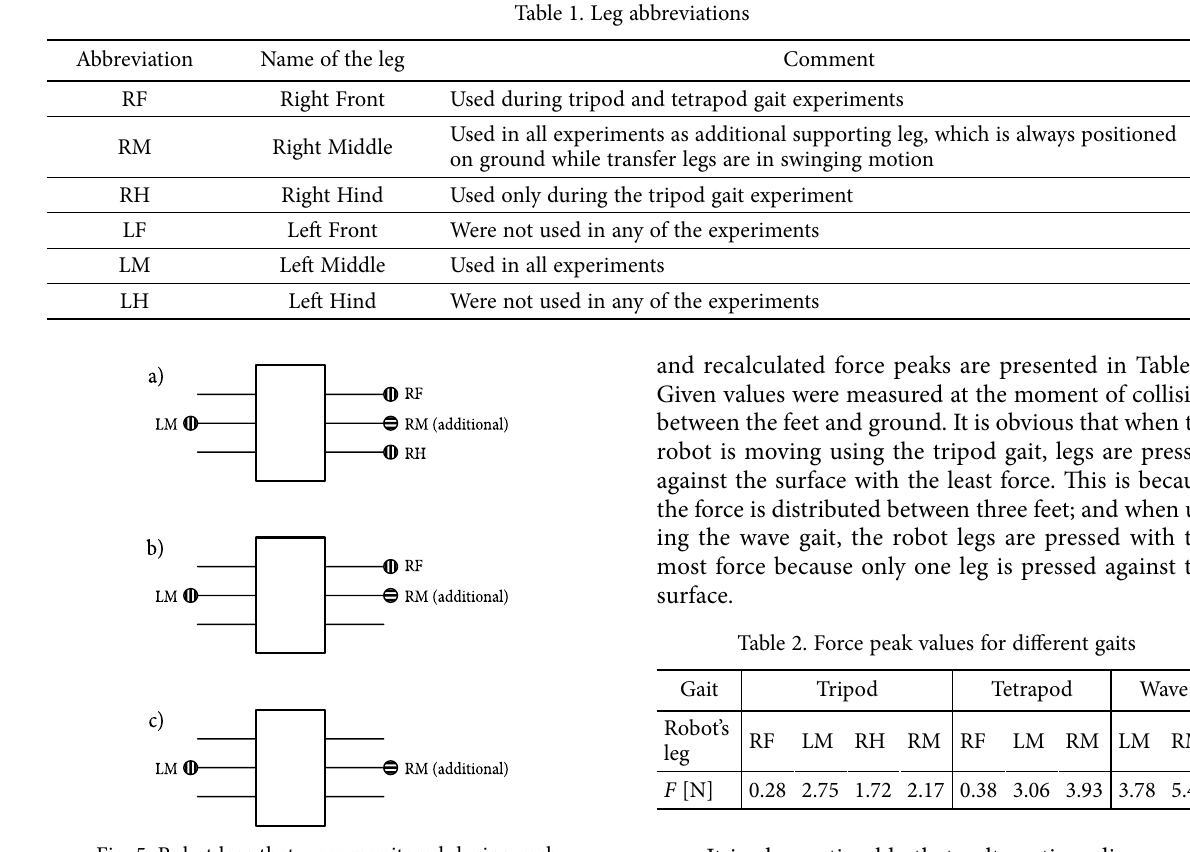
Fig. 5. Robot legs that were monitored during each